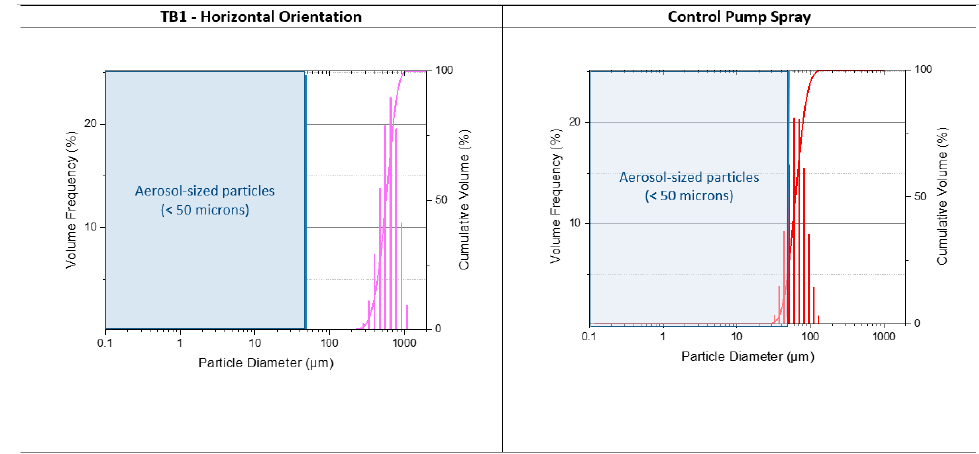
Figure 3. Particle size distribution of emitted particles from TB1 (horizontal orientation) and control spray—Malvern analysis.